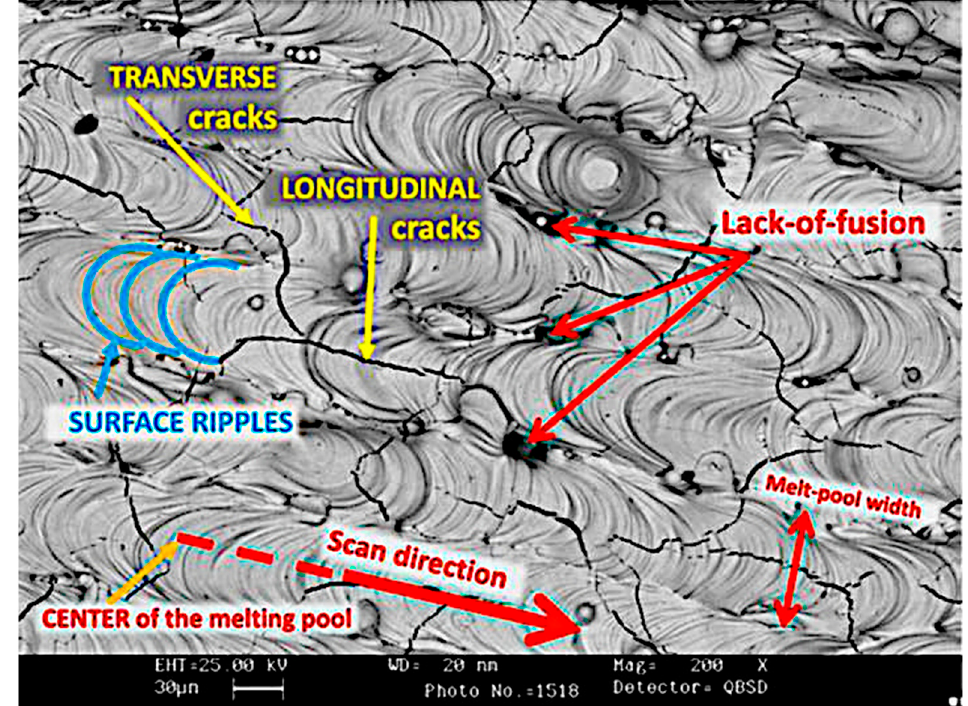
Figure 13. Crack on the tungsten surface in LPBF processed sample [58].